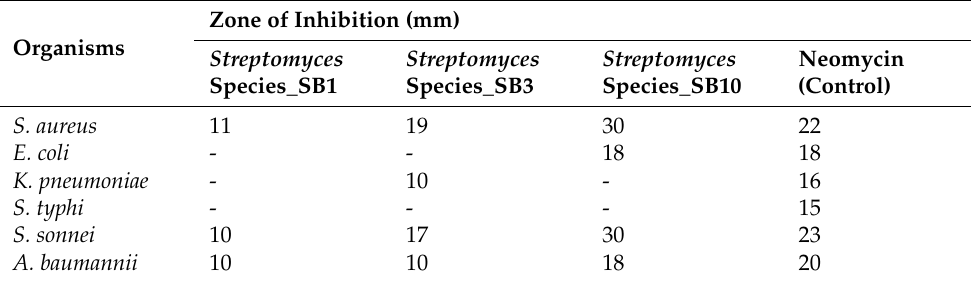
Table 2. Zones of inhibition exhibited by Streptomyces isolates.